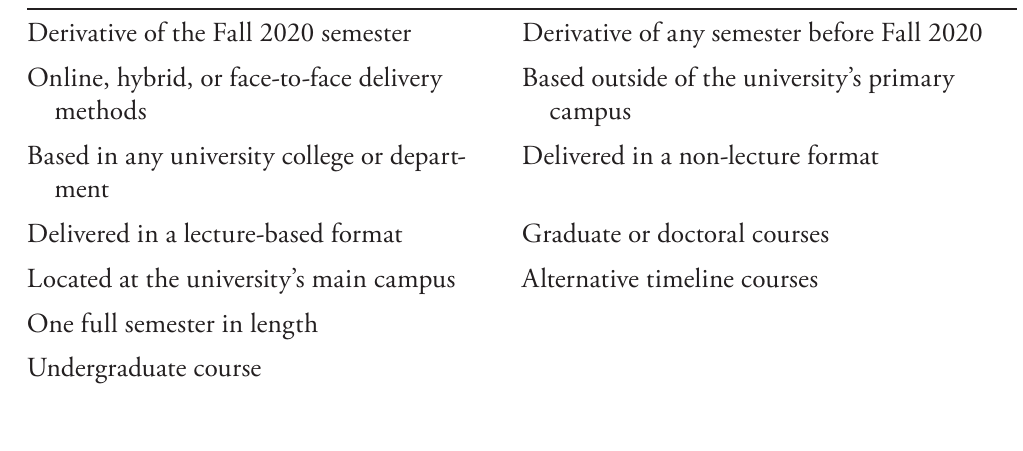
Table 2. Categories for Coding and Their Corresponding Definitions